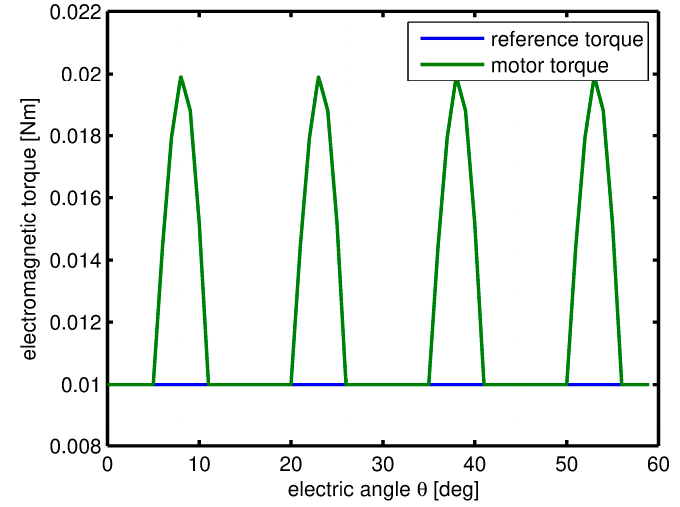
Figure 5. Torque waveform for the TSF method with an exponential waveform.